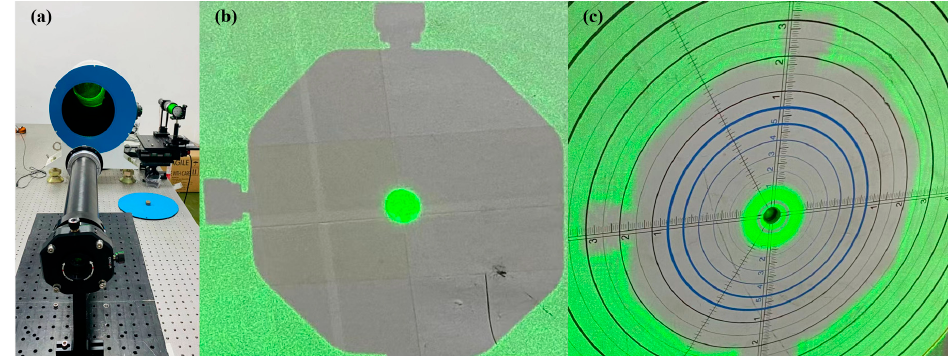
Figure 11. ( a ) Parallel light pipe test system. ( b ) Near-field spot. ( c ) Far-field spot.